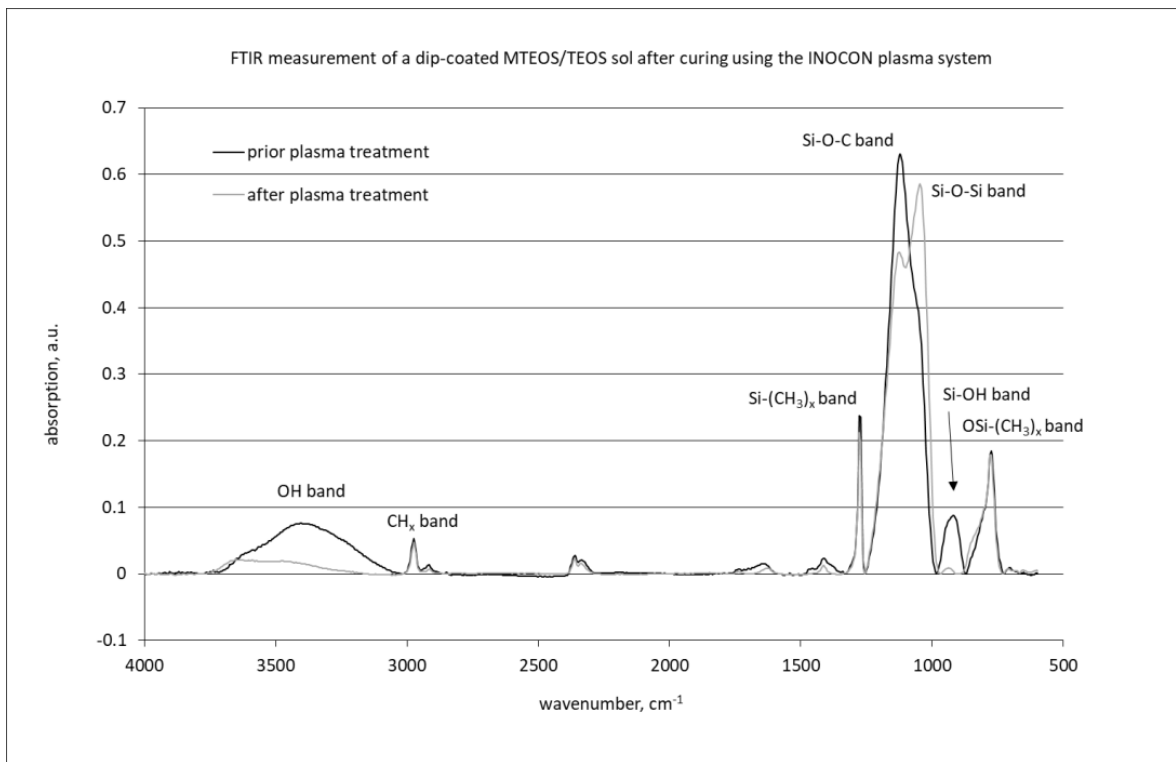
Figure 3. FTIR spectra of as-deposited and plasma-cured MTEOS-TEOS sol – gel film.